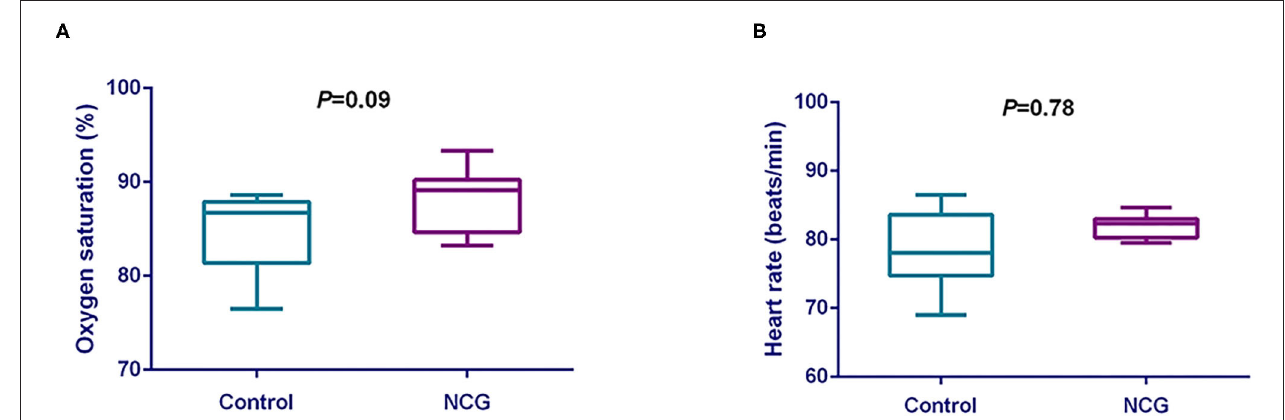
FIGURE 1 | (A) Comparative analysis of the effect of NCG on oxygen saturation of experimental Jersey cattle. (B) Comparative analysis of the effect of NCG on heart rate of experimental Jersey cattle. The blue box represents the diet without NCG supplementation (Control, CON group, N = 6), and the purple box represents the